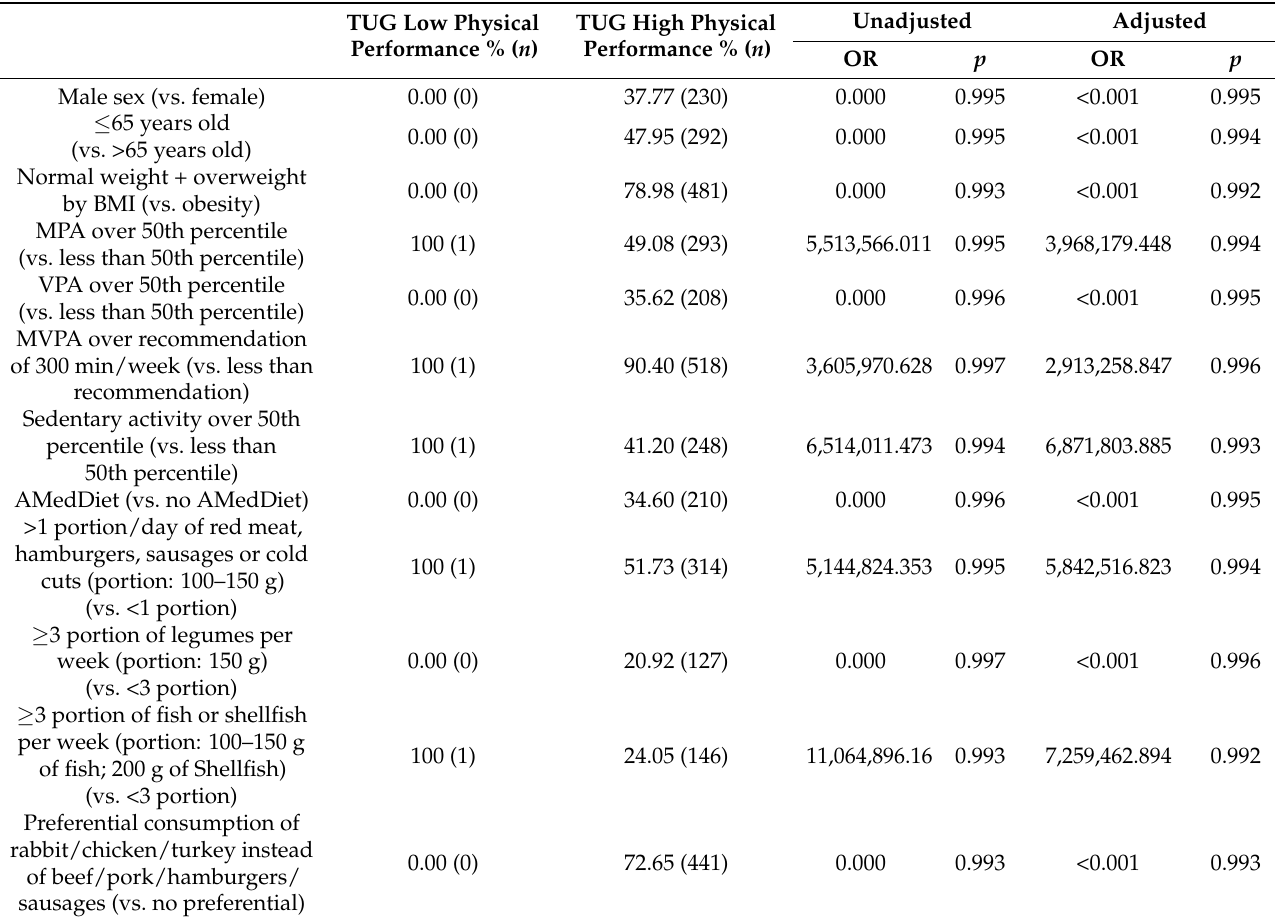
Table 8. Odds ratio of physical performance by TUG unadjusted and adjusted by sex and age. TUG Low